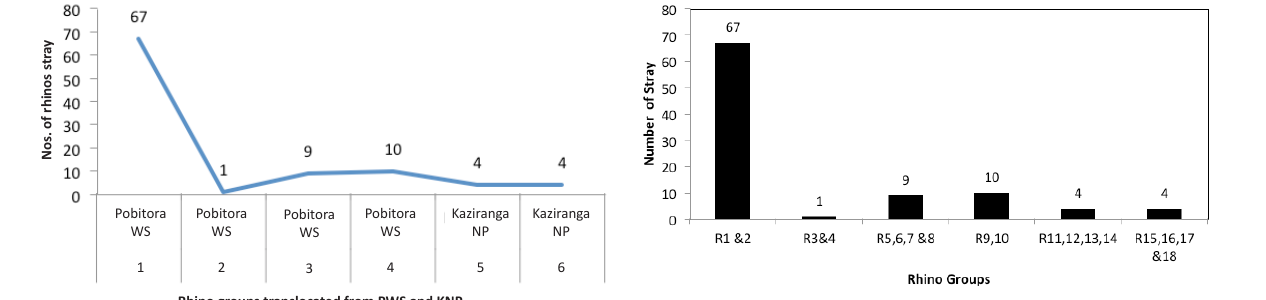
Figure 15. Group wise stray occurrences after being released at Manas National